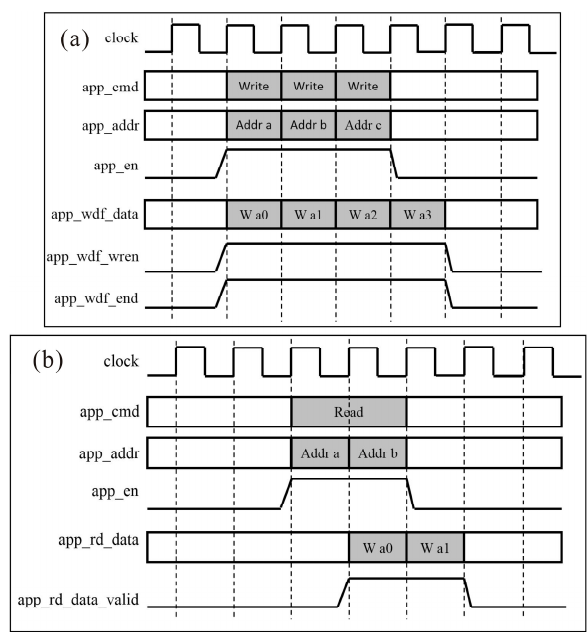
Figure 4. Sequential relationship of writing ( a ) and reading ( b ).